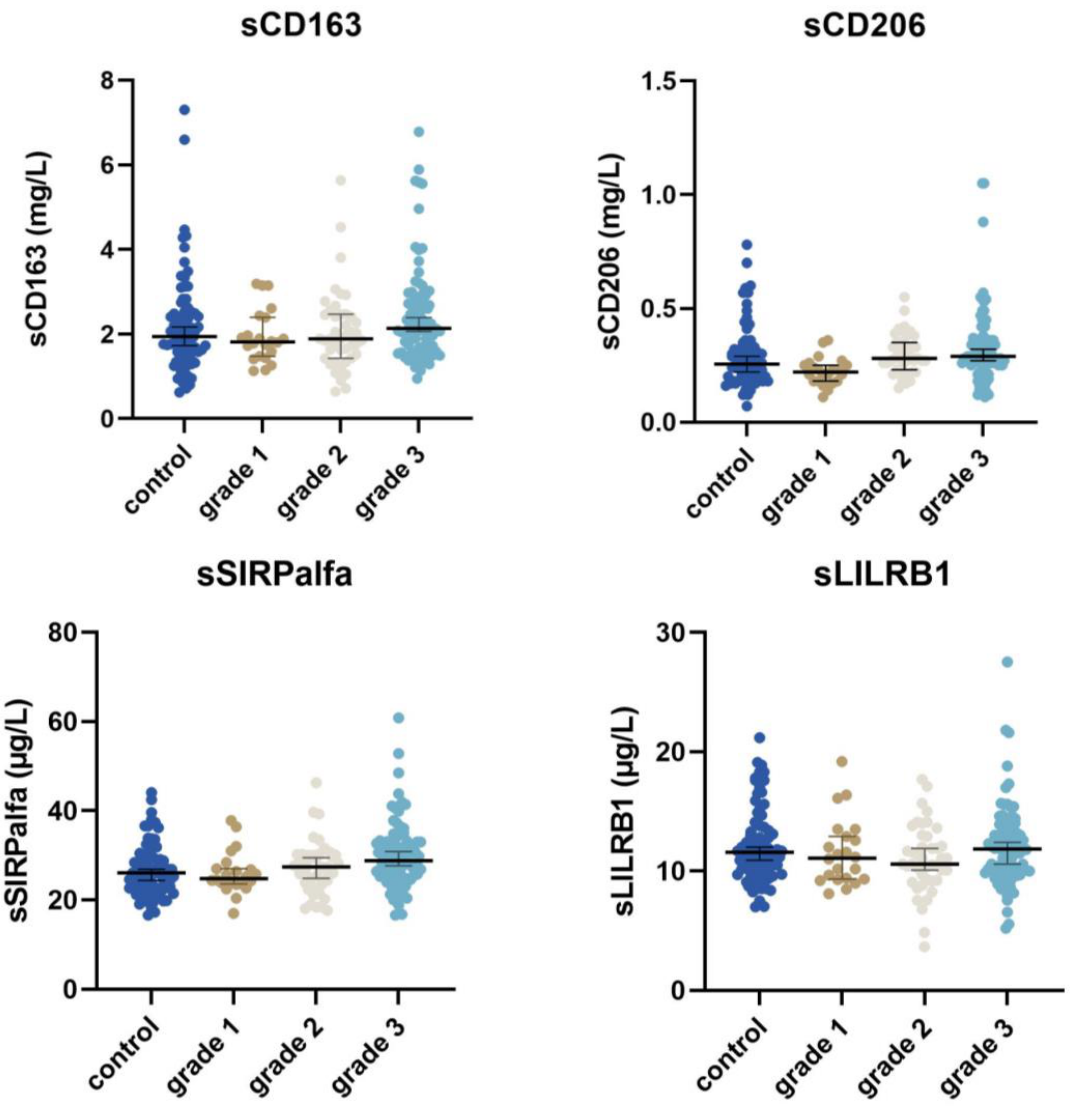
Figure 5. The concentration of the four different macrophage biomarkers according to tumour grade, as well as the control group.